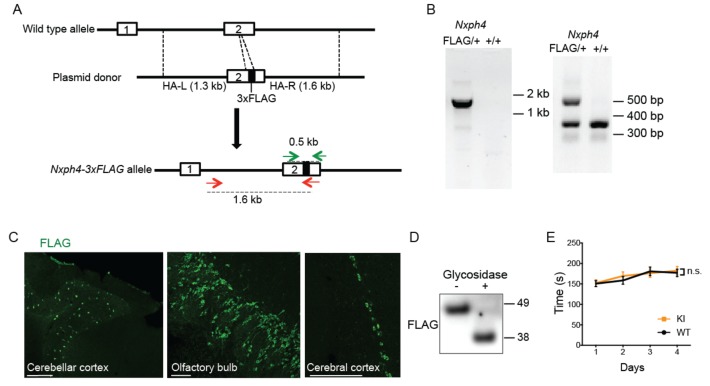
Generation and characterization of Nxph4-3xFLAG knock-in mice.(A) A schematic diagram of the strategy to generate an Nxph4-3xFLAG knock-in allele. An sgRNA is designed to excise the coding region corresponding to the C-terminal region of Nxph4 third domain. In the donor vector, the 3xFLAG sequence is inserted after the sequence of Nxph4 third domain. The homologous arms of the donor vector are indicated as HA-L and HA-R. Two pairs of primers designed for genotyping are shown with green and red arrows. (B) Representative genotyping results using two different pairs of primers to distinguish Nxph4FLAG/+ from Nxph4+/+ mice. Left, the forward primer is outside of the HA-L and the reverse primer in within 3xFLAG region (red arrows in A). Right: the forward and the reverse primers flank the 3xFLAG sequence (green arrows in A). (C) Representative immunofluorescence images illustrate the expression of Nxph4-3xFLAG in specific brain regions. Scale bars: 200 μm. (D) Treatment with glycosidase altered the electrophoretic motility of Nxph4-3xFLAG. (E) Latency to fall from the accelerating rod (mixed male and female mice, n = 17–19). Data are presented as mean ± SEM. n.s., not significant; by two-way ANOVA.